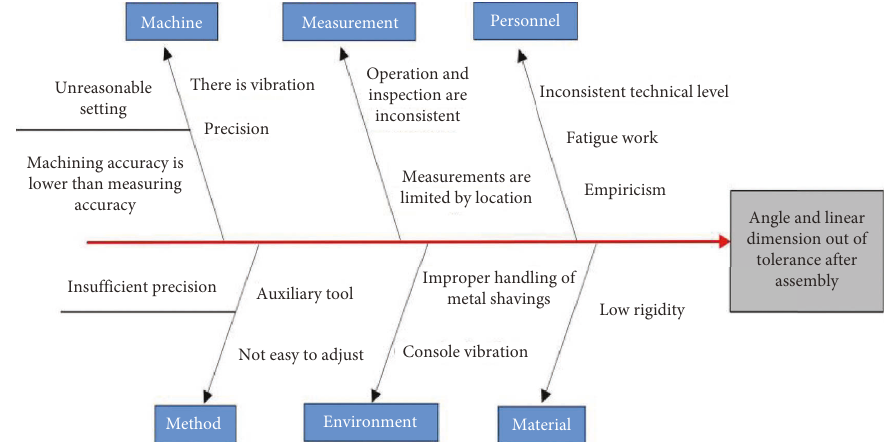
Figure 1: Classification of mold out-of-tolerance